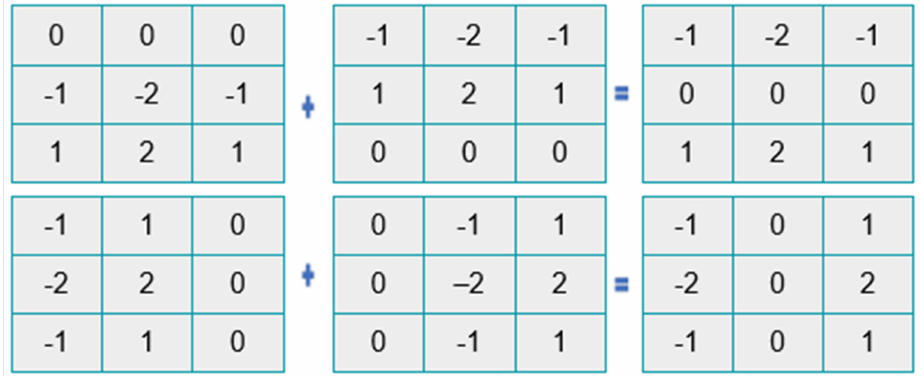
Figure 5. The adapted Sobel